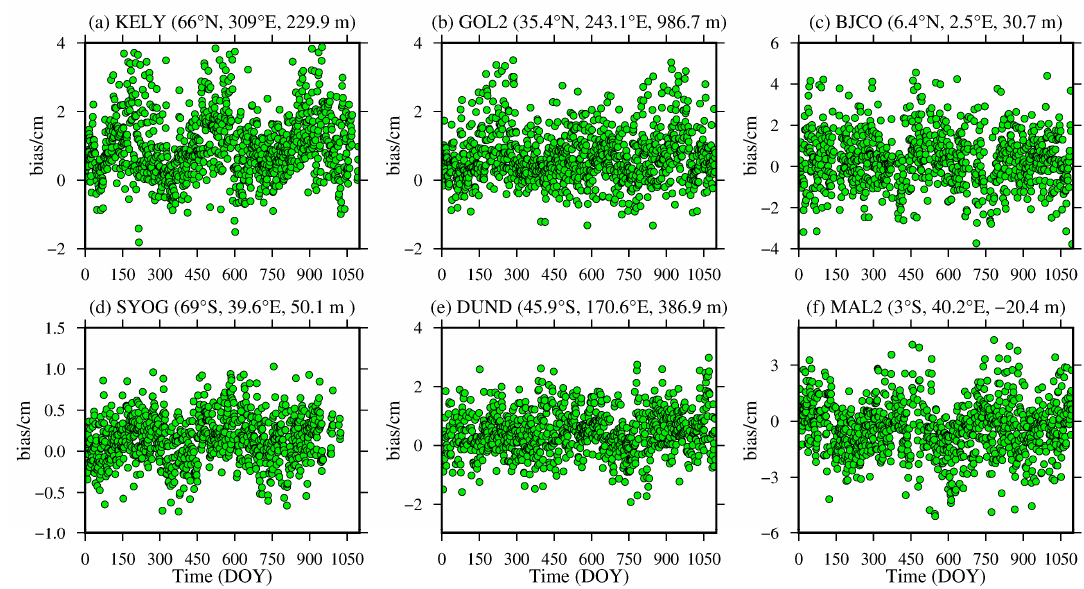
Figure 4. ZTD bias time series of the ( a ) KELY, ( b ) GOL2, ( c ) BJCO, ( d ) SYOG, ( e ) DUND and ( f ) MAL2 stations derived from the MERRA-2 data from 2015 to 2017 (the content in parentheses indicates the latitude, longitude and altitude of the IGS station).